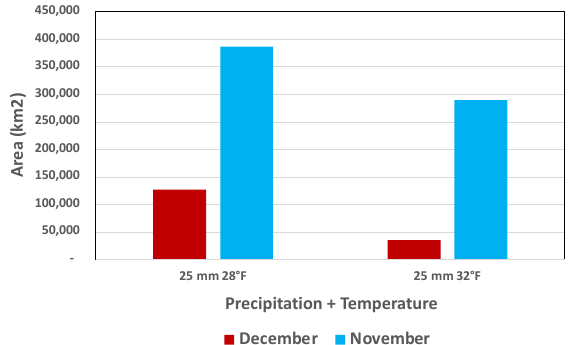
Figure 7. Comparison of all combinations of precipitation (25 mm threshold) and temperature (at 32 °F and 28 °F) for November and December (all 10th percentile) (note: 32 °F = 0 °C, 28 °F = −2.2 °C).